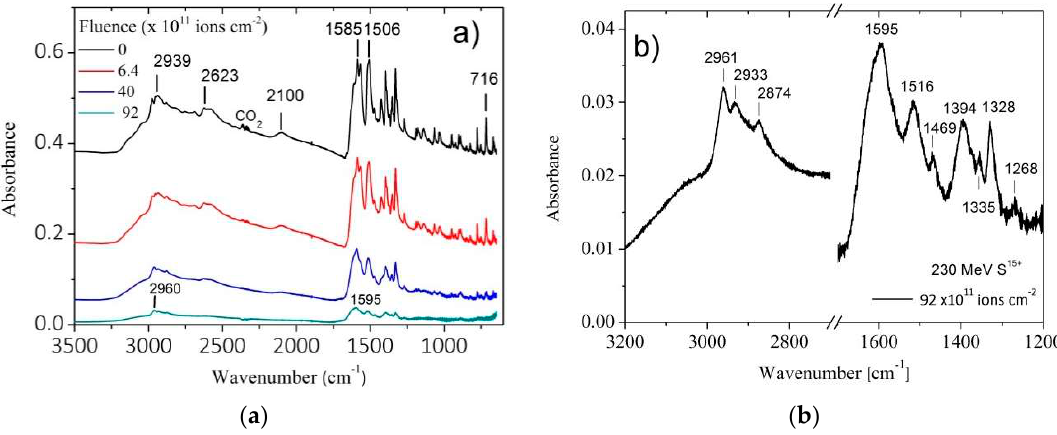
Figure 6. ( a ) Valine IR spectra as a function of projectile fluence. The first spectrum at the top corresponds to the non-irradiated sample and the 4th one was acquired at the end of the irradiation. ( b ) Zoom of the 3200–2700 and 1700–1200 cm − 1 regions for the highest fluence measurement.